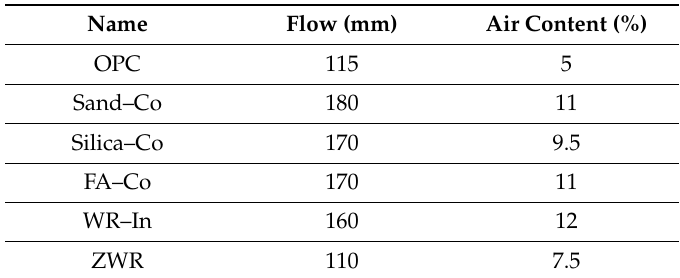
Table 9. Result of the cement mortar flow test and air content test.